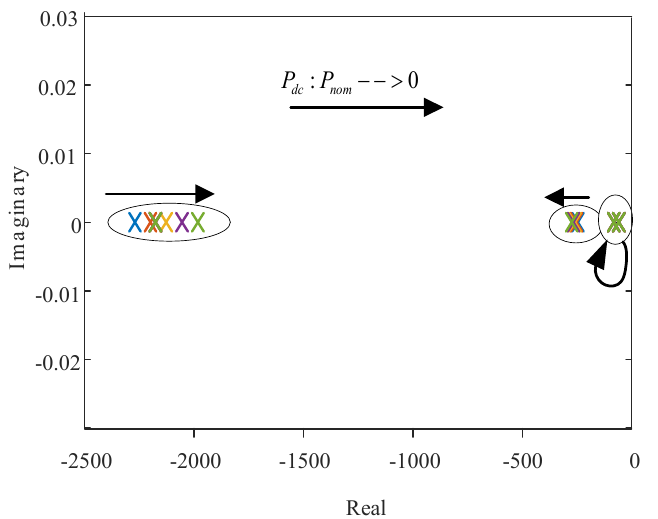
Figure 4. The poles of the overall control system with conventional controller in different operating points without observer.